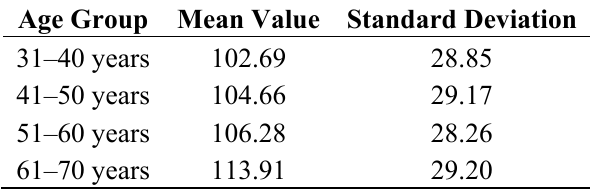
Table 4. Skin roughness (Rz parameter) mean basal values and standard deviations.